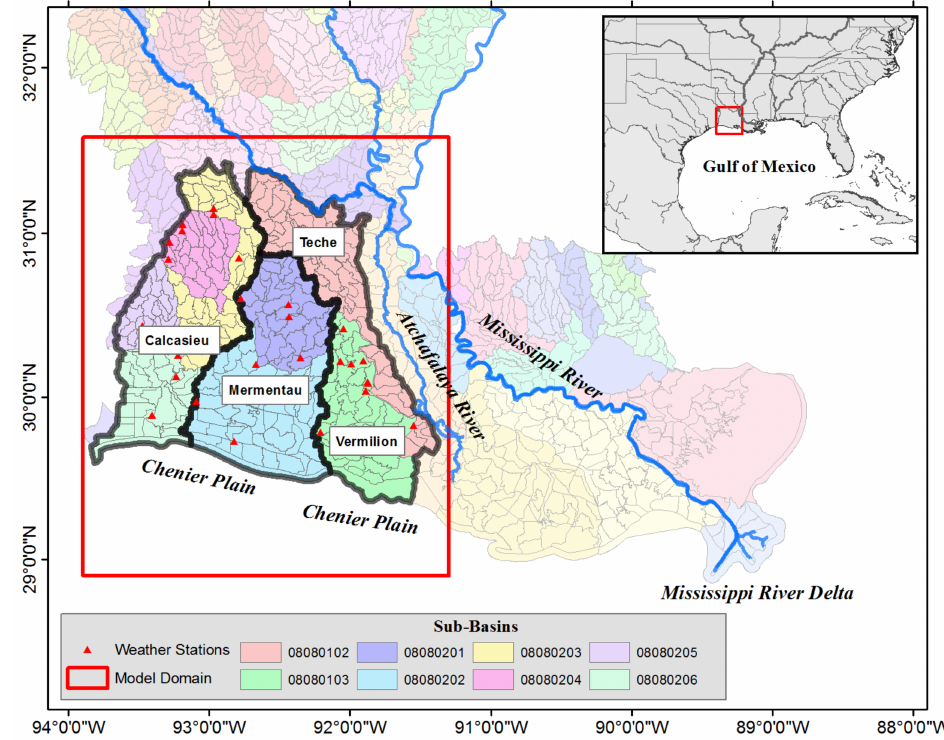
Figure 1. Calcasieu, Mermentau, and Vermilion-Teche basins and their sub-basins (data source: National Hydrography Dataset). Also shown are locations of the National Oceanic and Atmospheric Administration (NOAA) weather stations (red triangles) and WRF-Hydro model domain (red